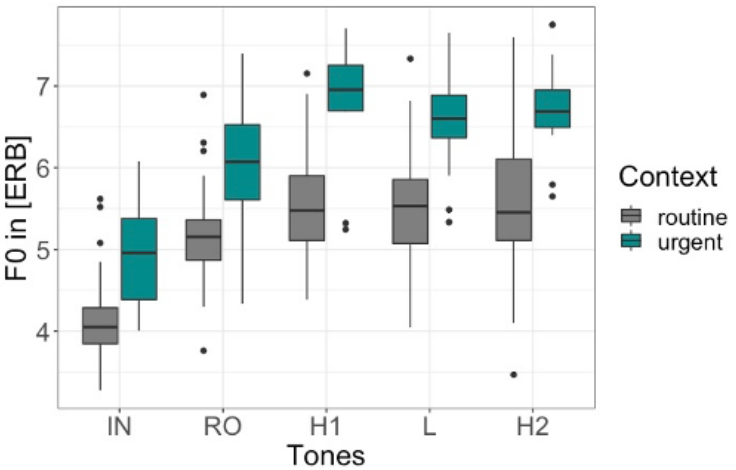
Figure 8. F0 scaling of the chanting contour in the routine and urgent context in